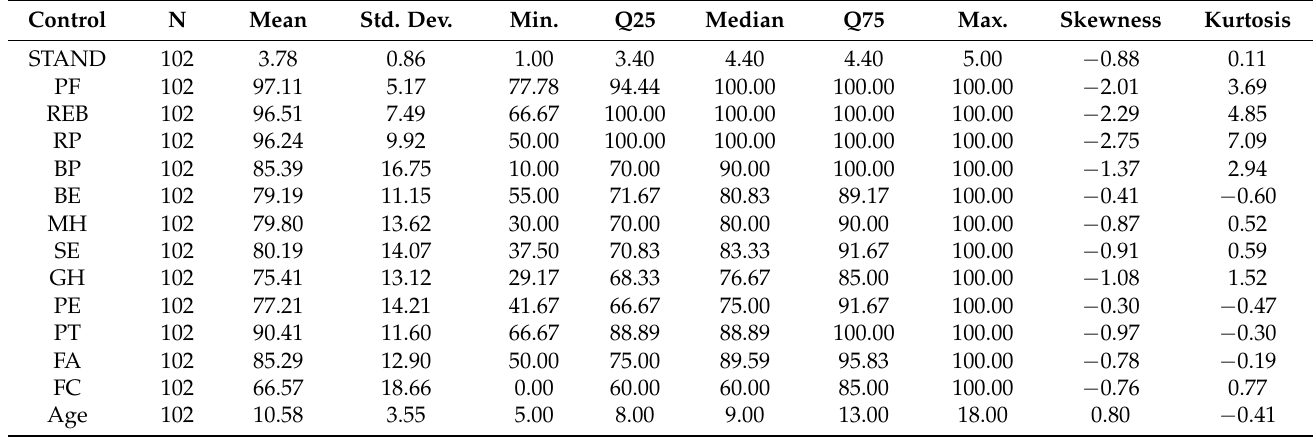
Table 1. Summary statistics—continuous variables for the control group.